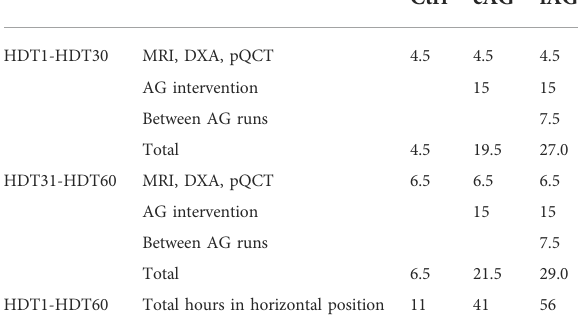
TABLE 3 Positional deviation from 6 ° HDT. The table indicates the number of hours during which the individuals in each experimentalgroupwereinthehorizontalposition(0 ° )duringthe60- days HDT phase. These include the MRI, DXA, and pQCT exams, the AGinterventions,andtherestperiodsbetweentheAGrunsduring the iAG